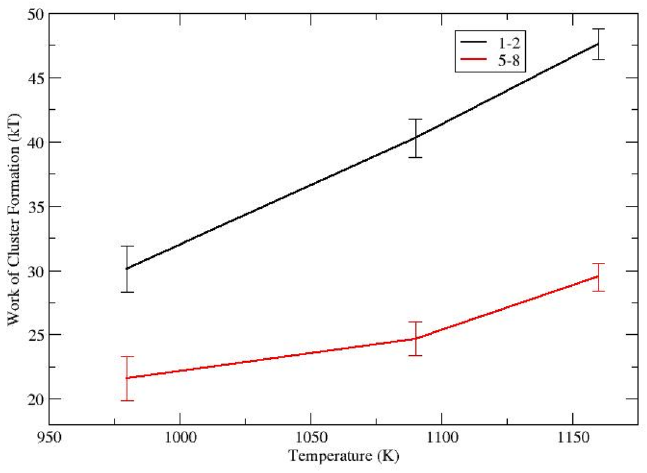
Figure 1. The work of cluster formation in barium silicate as function of temperature for the 1–2 and 5–8